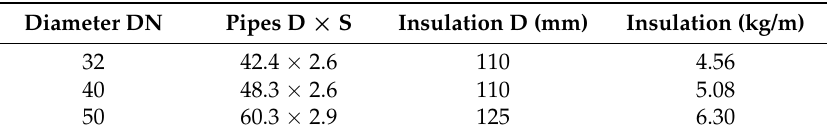
Table 4. Pipe diameter and